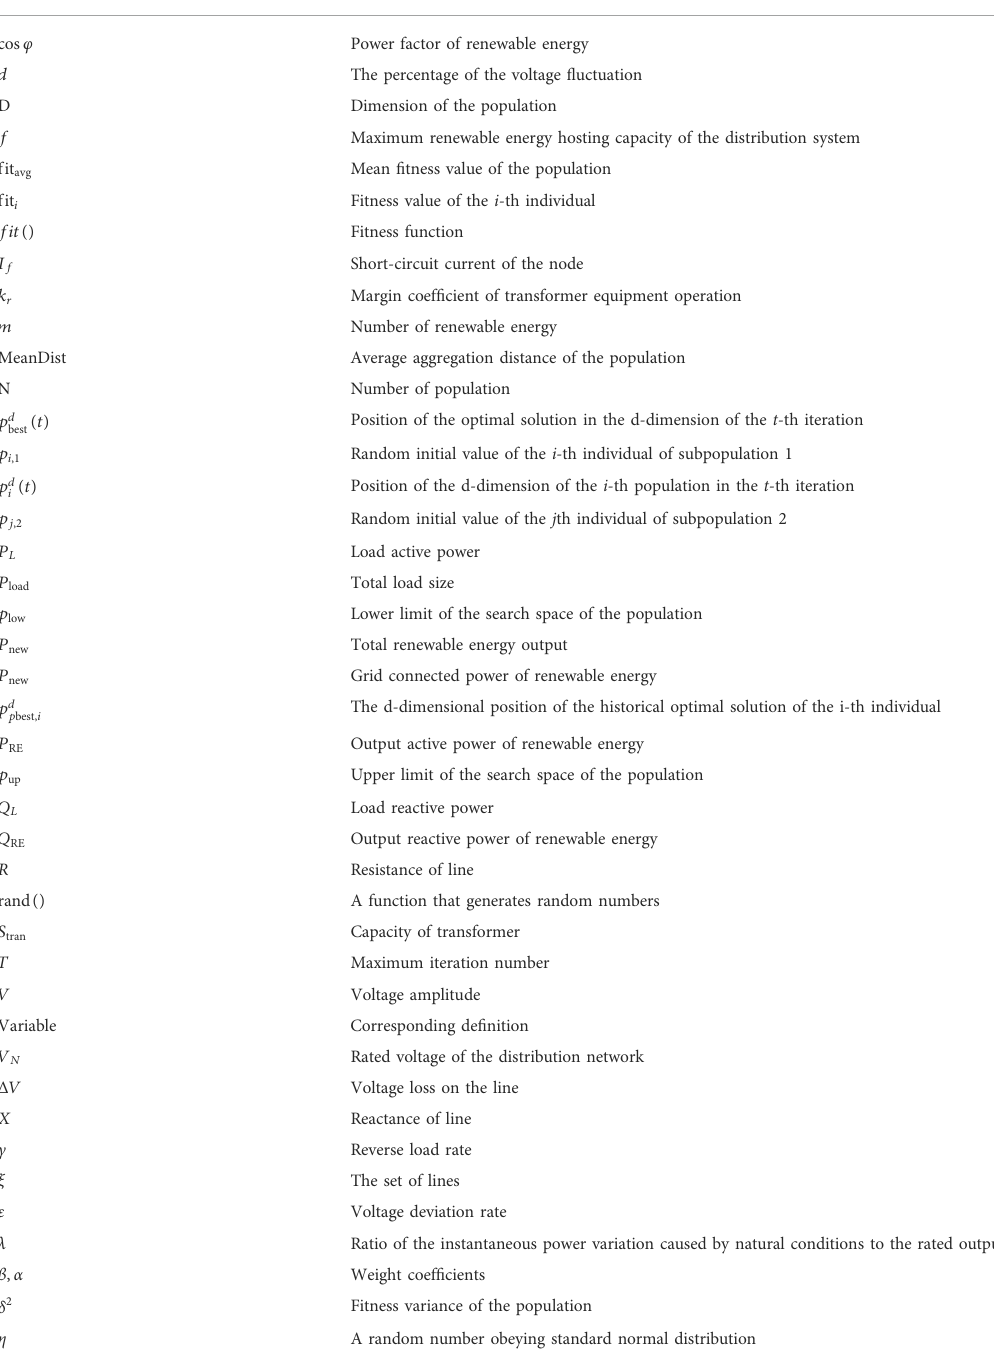
TABLE 1 The variables and corresponding de fi